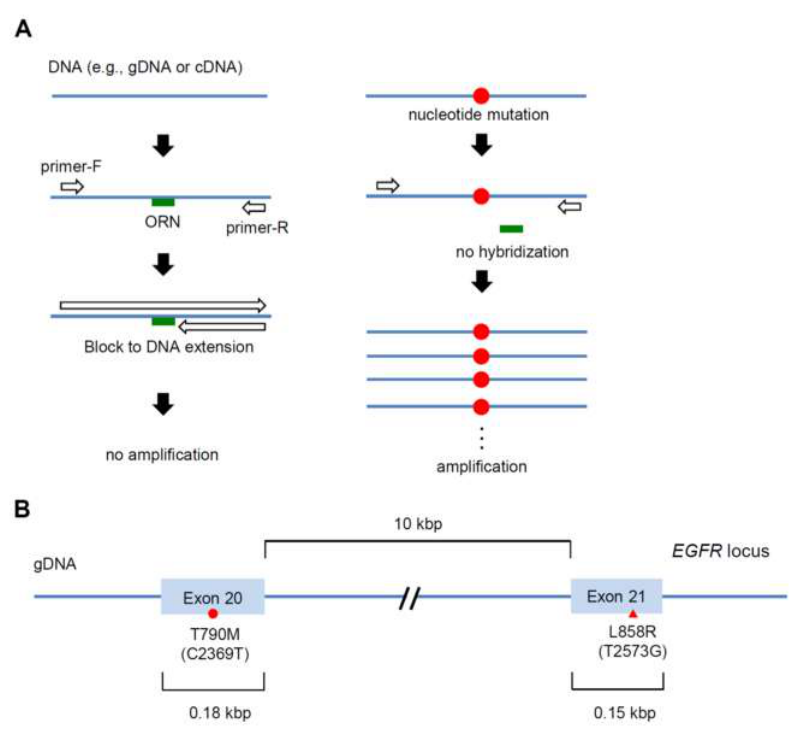
Figure 1. Schematic diagram of ORNi-PCR for detection of single-nucleotide mutations in the human EGFR gene. ( A ) Schematic diagram of ORNi-PCR for detection of a single-nucleotide mutation. ( B ) Major clinically relevant single-nucleotide mutations in the human EGFR gene. T790M (C2369T) and L858R (T2573G) are in exons 20 and 21, respectively.